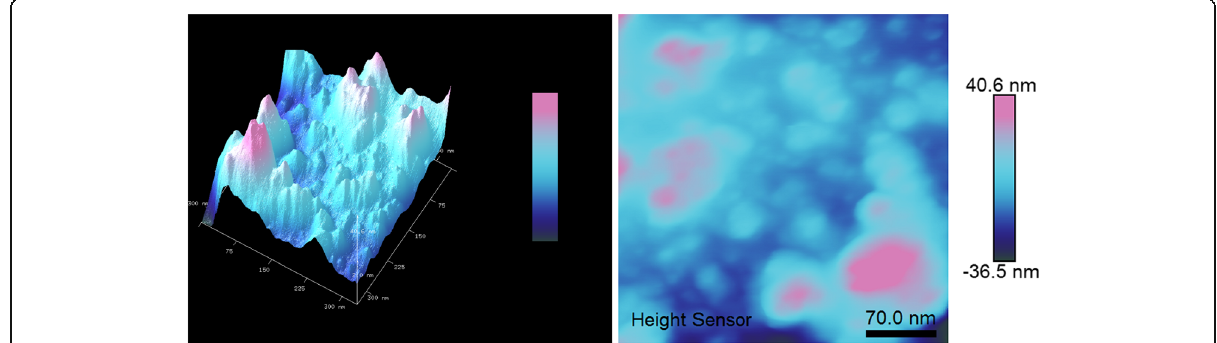
Fig. 12 Maghemite nanoparticles synthesized through yttrium directed sol-gel, dispersed onto silicon wafer and imaged with AFM. The same image is represented in 3D and